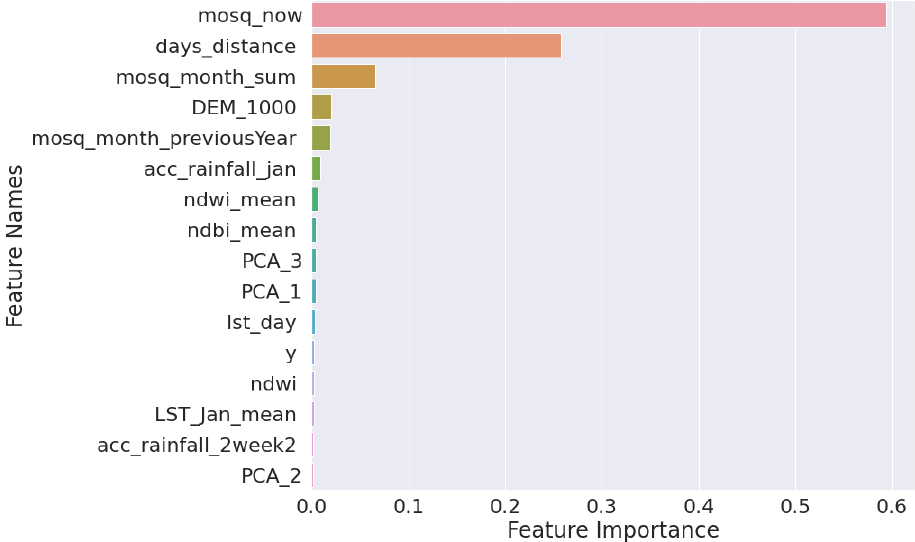
Figure 4. Feature importance of Culex Italy case using both EO and entomological